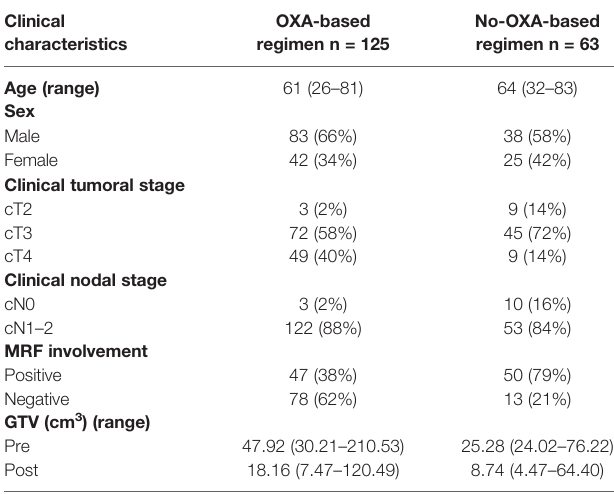
TABLE 1 | Clinical characteristics of patients enrolled and treated with and without oxaliplatin. Clinical